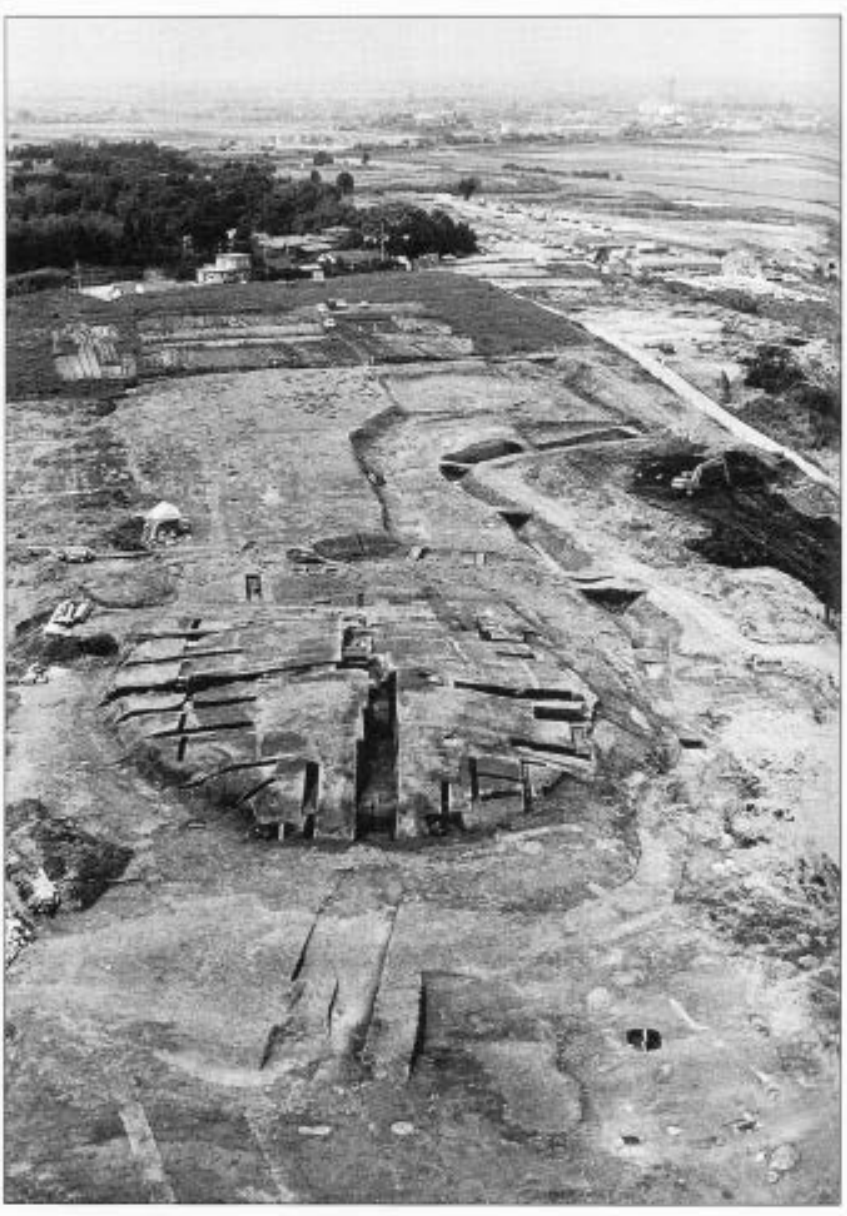
Figure4 The compound cemetery at Yoshinogari under excavation in 1989. The largest burial pit (the supposed burial place of the "king" of a regional unit) can be seen at the centre of the